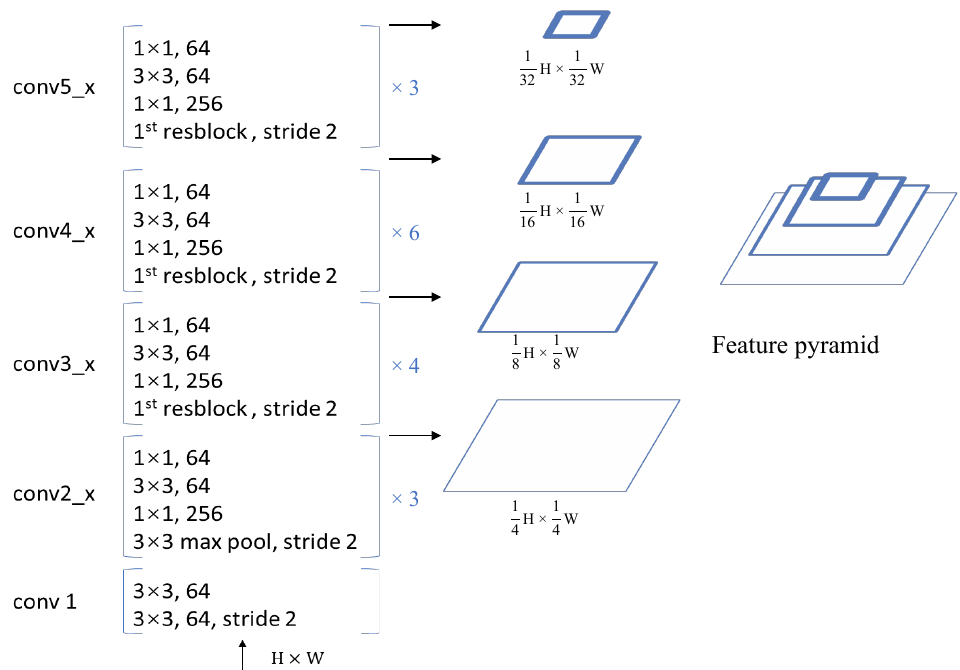
Figure 1. The structure of Resnet50 and its output feature pyramid. Note that H and W denote the height and width of the input image,